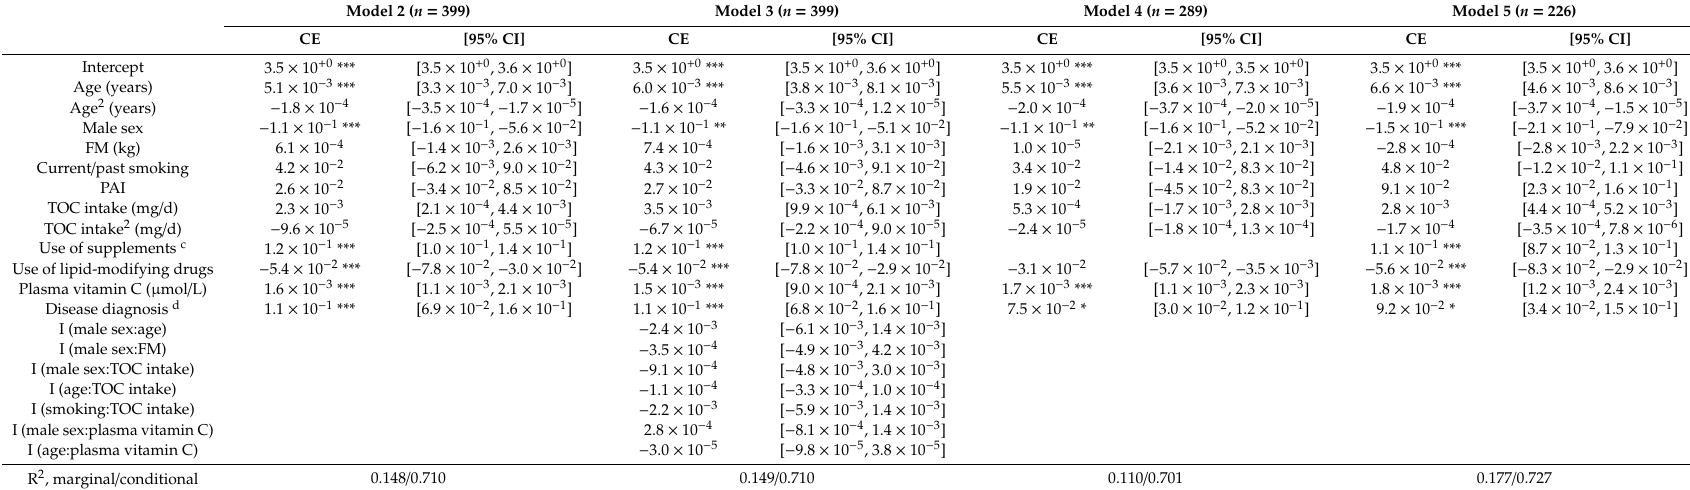
Table 3. Results of linear mixed-e ff ects models for determinants of log plasma α -tocopherol concentrations a,b